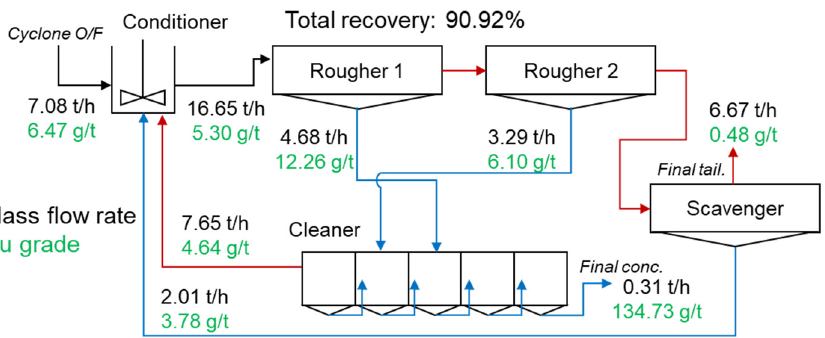
Figure 10. Simulated mass balance of current process using alternative process of Case 1. Blue line represents stream of floated products, and red line represents stream of sinked products after flotation. Black text is the mass flow rate. Green text is the gold grade at each node.